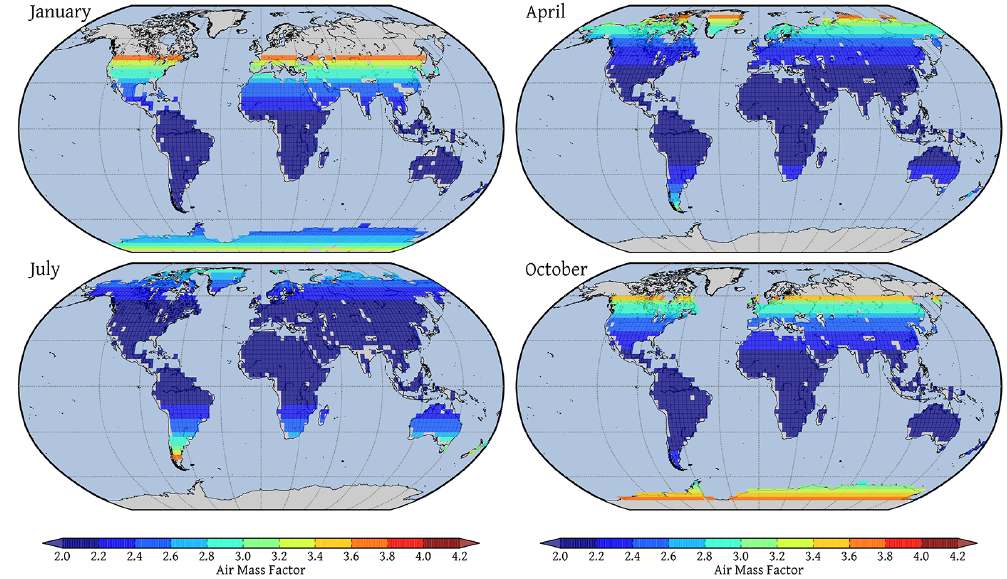
Figure 4. Air mass factor (AMF) for the four months considered. Latitudes with solar zenith angles larger than 70 ◦ were